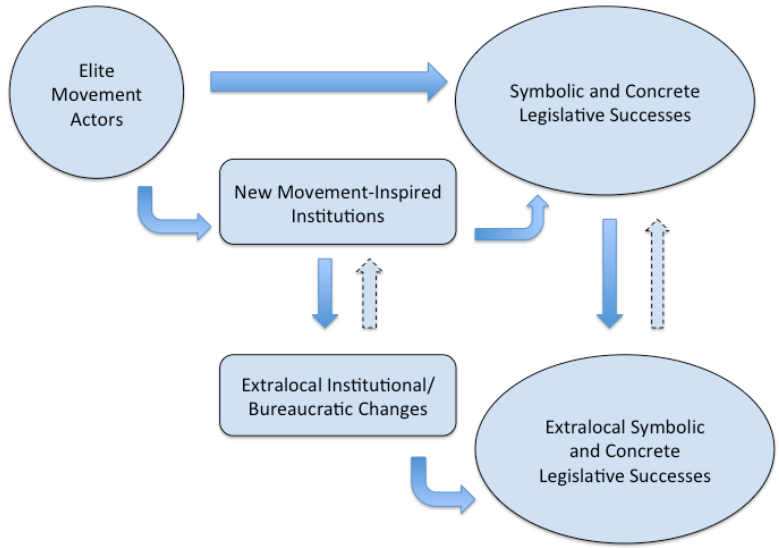
Figure 5. Model of long ‐ term and second order policy impacts.